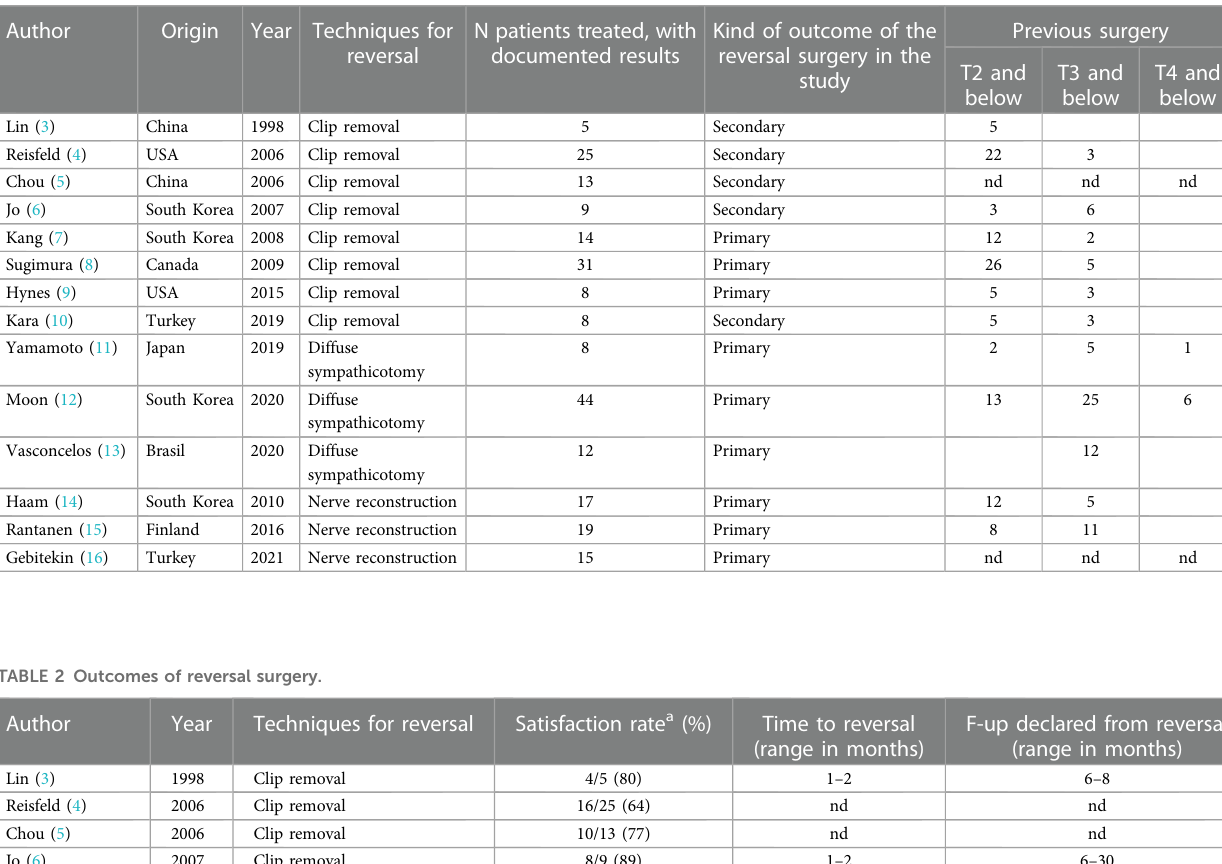
TABLE 1 Characteristics of the studies.